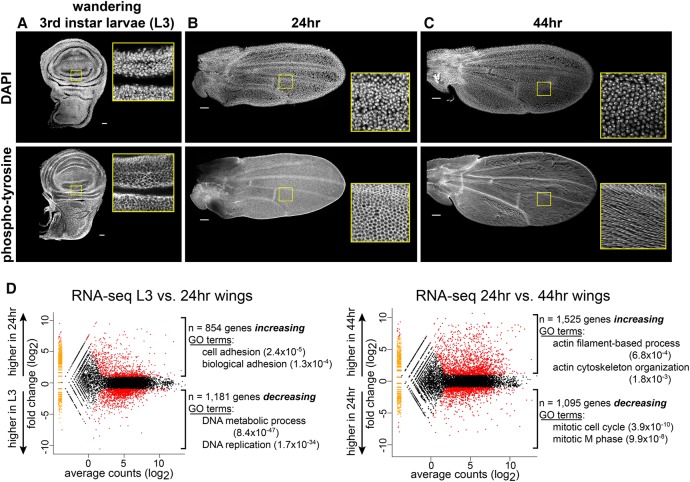
Gene expression is temporally dynamic in pupal wings. (A–C) Immunostaining of wings from three developmental time points. DAPI (top row) and phospho-tyrosine (bottom row) label nuclei and cell membranes, respectively. (D) MA plots of RNA-seq signal in annotated genes for consecutive time points. Differentially expressed genes are colored red. The top two GO terms for differentially expressed genes are indicated with P-values in parentheses. Bars, 50 µm.